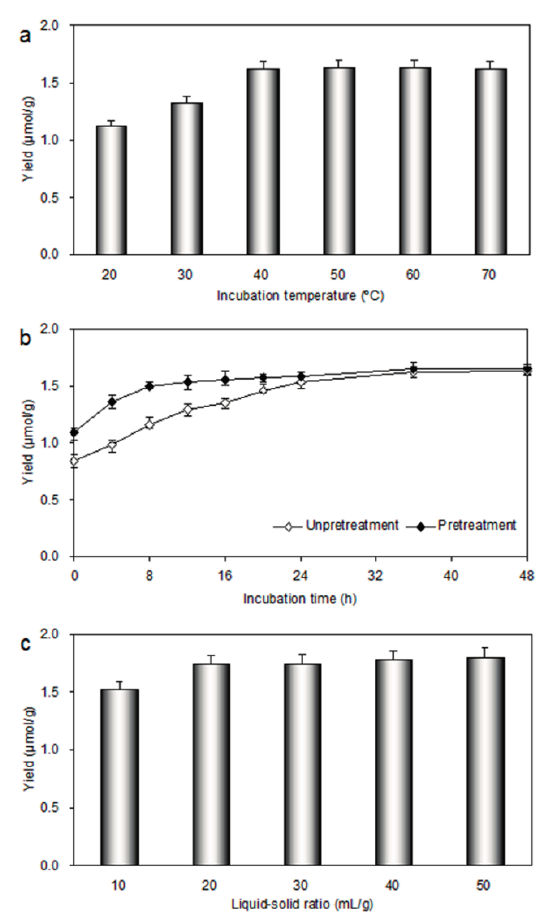
Figure 4. Effect of different parameters in EHSE process on the yield of genipin: ( a ) incubation temperature (°C); ( b ) incubation time (min); and ( c ) liquid–solid ratio (mL/g). Different amounts of degreased sample powder were added into 10 mL deionized water and pretreated with microwave at 500 W for 10 min. The samples were then mixed with 5.0